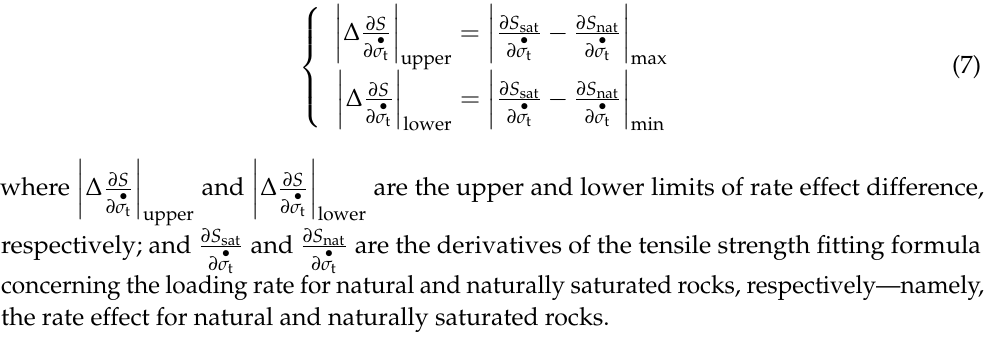
Table 3. Rate effect difference of natural and naturally saturated sandstone